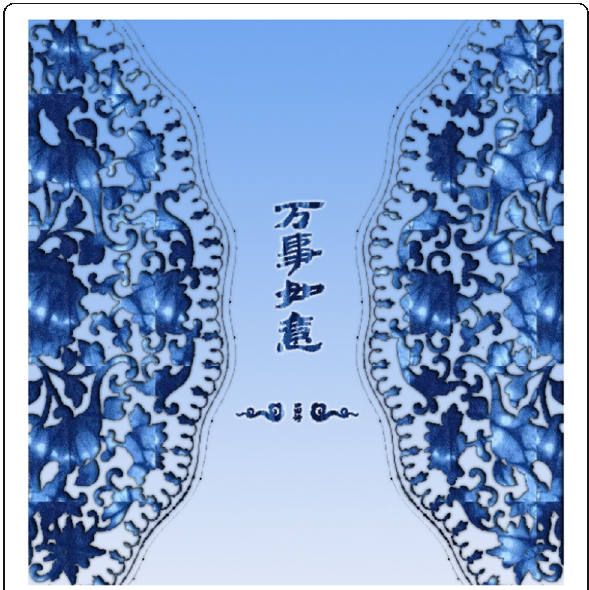
Fig. 2 Computer software technology reorganization tie-dye pattern